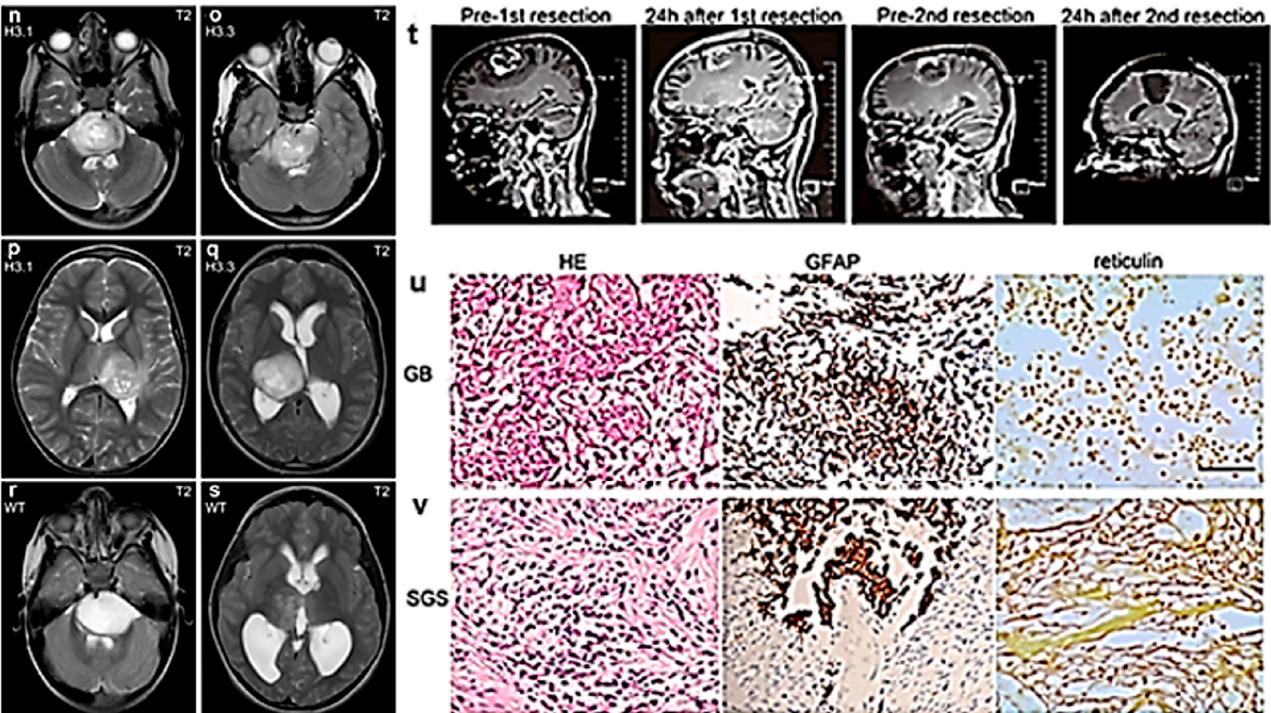
Figure 2. Advances in imaging diagnosis of HGG. PCNSL. ( a ). Axial T-2. ( b ). DWI. ( c ). Postcontrast studies demonstrate an intensely enhancing mass in the left frontal lobe with a mild T-2 dark signal and T-2 shortening, demonstrating DWI restriction and marked contrast enhancement. ( d , e ). Co- registered perfusion with postcontrast T1 volumetric and perfusion curves demonstrate low blood volume relative to white matter in spite of significant enhancement in the postcontrast studies and a significantly higher percentage signal recovery than that of normal white matter (pink region of interest (ROI) representing tumor and blue ROI normal white matter). Percentage signal recovery curve showing that is characteristically higher than base line recovery is. ( f ). Magnified version of perfusion graph, highlighting the difference in percentage signal recovery values between PCNSL and normal white matter (pink = tumor; yellow = white matter; red = mean of entire slice). GB. ( g ). Axial T2. ( h ). DWI ( i ). Apparent diffusion coefficient (ADC): there is a mass of T2 heterogenous intensity within the right basal ganglia, with DWI restriction and low ADC, closely resembling lymphoma. ( j – l ). Perfusion study demonstrating high blood volume and low PSR. In contrast to PCNSL, GB demonstrates significantly lower percentage signal recovery than normal white matter does. ( m ). Magnified version of PSR (blue arrows), showing the difference of signal recovery values between the tumor and white matter (pink = tumor; white = white matter; yellow = mean of tissue slice) (reproduced from [15] with permission). Typical localizations of pDMG in the pons ( n , o ) and thalamus ( p , q ) in axial MR images. Different H3K27 genetic subgroups may show very similar MRI phenotypes with hyperintense, heterogeneous T2 signal ( n – q ). However, T2 signal may also appear to be very different even within the same genetic group ( r , s ) (reproduced from [16] with permission). MRI and histopathological staining of brain tumor tissues. ( t ). Sagittal T1-weighted contrast-enhanced MRI imaging of initial and recurrent tumors. ( u , v ). Representative images of u. primary GB and ( v ). secondary gliosarcoma (SGS) tissues stained using hematoxylin and eosin (HE), and immunolabeled using antibodies to glial fibrillary acidic protein (GFAP) and reticulin (reproduced from [17] with